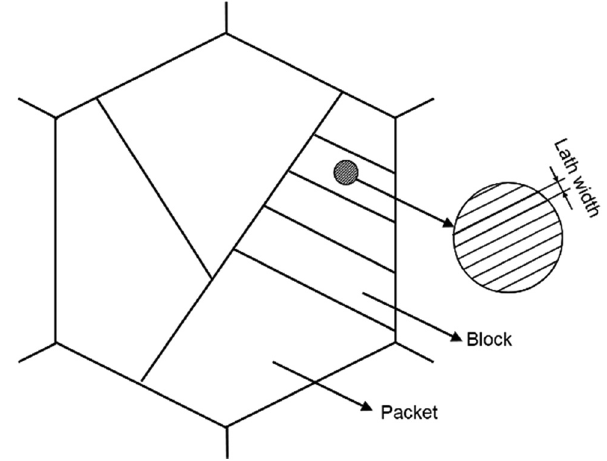
Figure 7: The dilatometric curves of BR500HS ( heat preservation at 640°C )